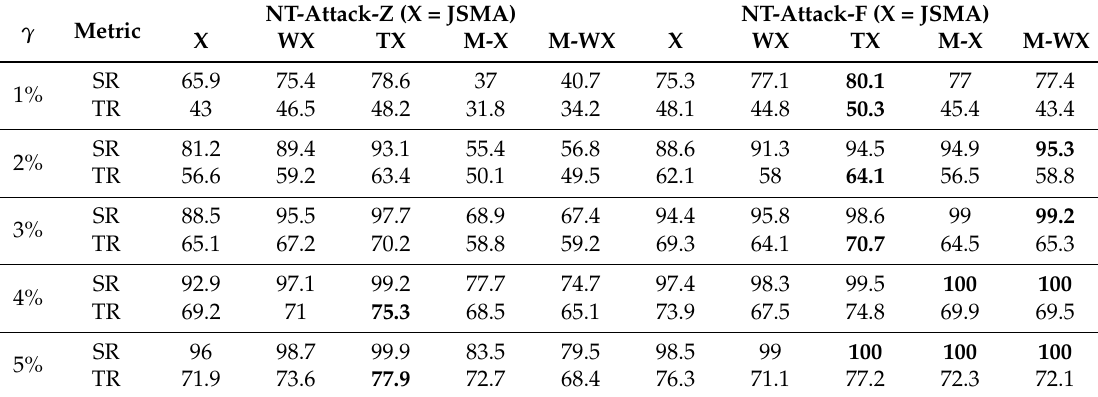
Table 7. Success and transferability rates (SR & TR) in % for the black-box NT attacks on the 1000 to 2000 test samples of GTSRB for a distortion γ varying from 1% to